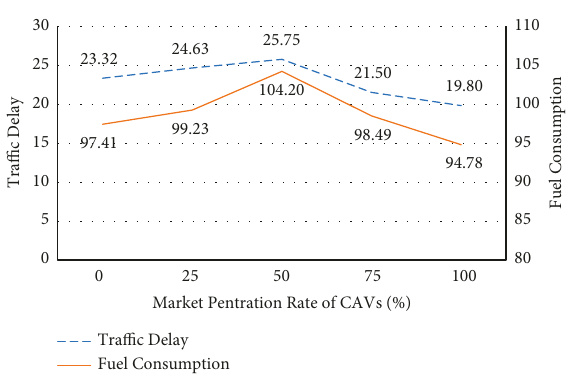
Figure 12: Analysis for different CAV market penetration